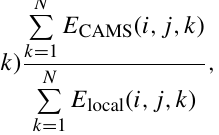
Figure 2. Flow chart illustrating the general methodology ap- plied to combine local information with the global dataset CAMS- GLOB-ANT